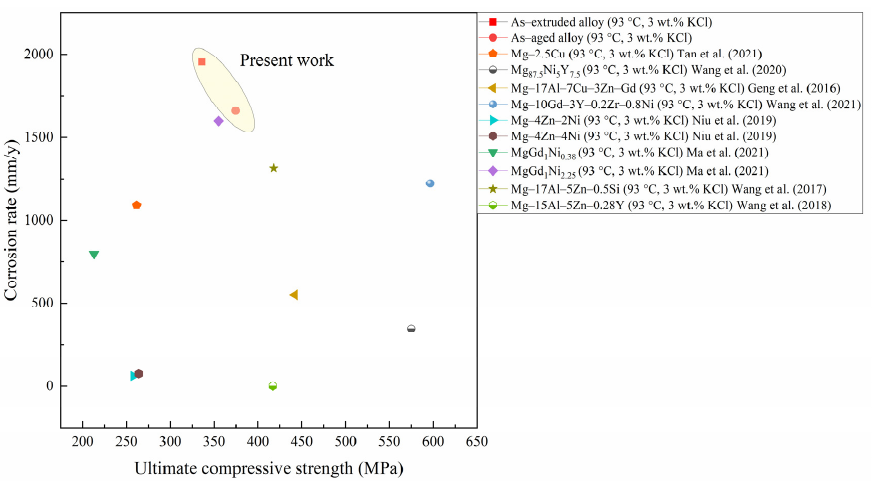
Figure 9. Comparison of the ultimate compressive strength and corrosion rate among the present Mg–Gd–Cu–Zr alloy and other Mg alloys for degradable fracturing ball